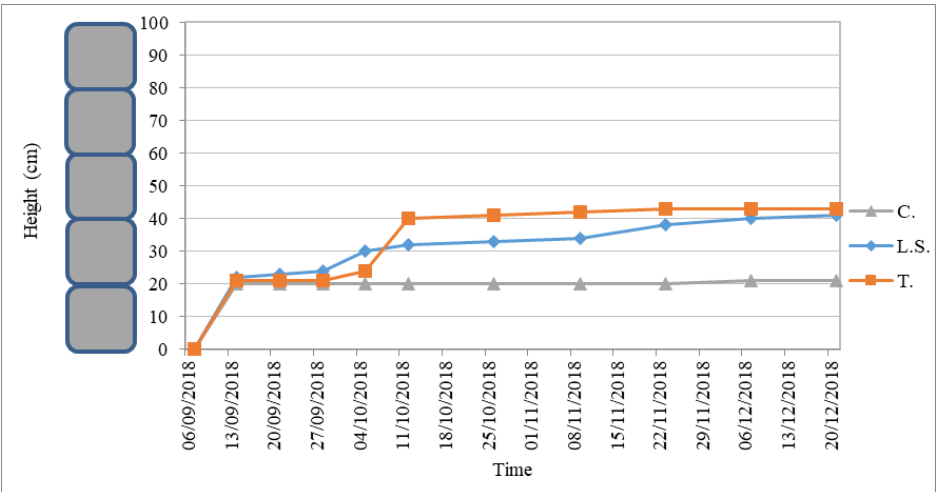
Figure 10. Ascent height-time absorption curves for carparo (C.), Lecce Stone (L.S), and tuff (T.).